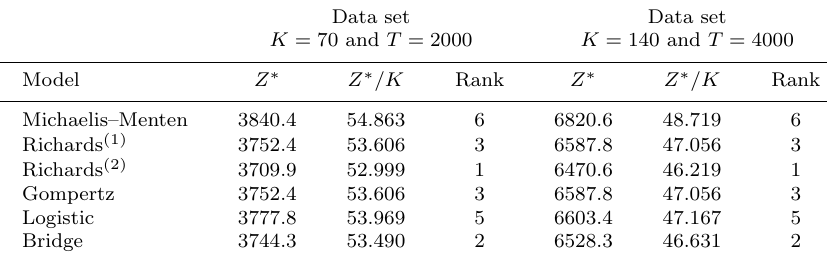
Table 4. Ranking criterion values for the